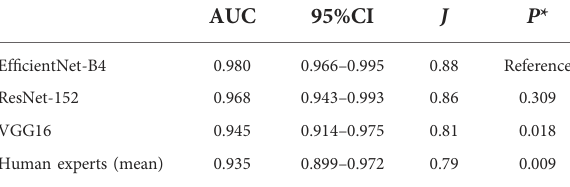
TABLE 2 Continuous data ROC analysis of CNN model predictions in percent and averaged human expert ratings for detection of pediatric distal radius torus fractures in PA wrist radiographs. AUC, area under the curve; 95% CI, con fi dence interval; J , Youden ’ s Index; P *, P -values relate to the comparison with Ef fi cientNet-B4, using the DeLong